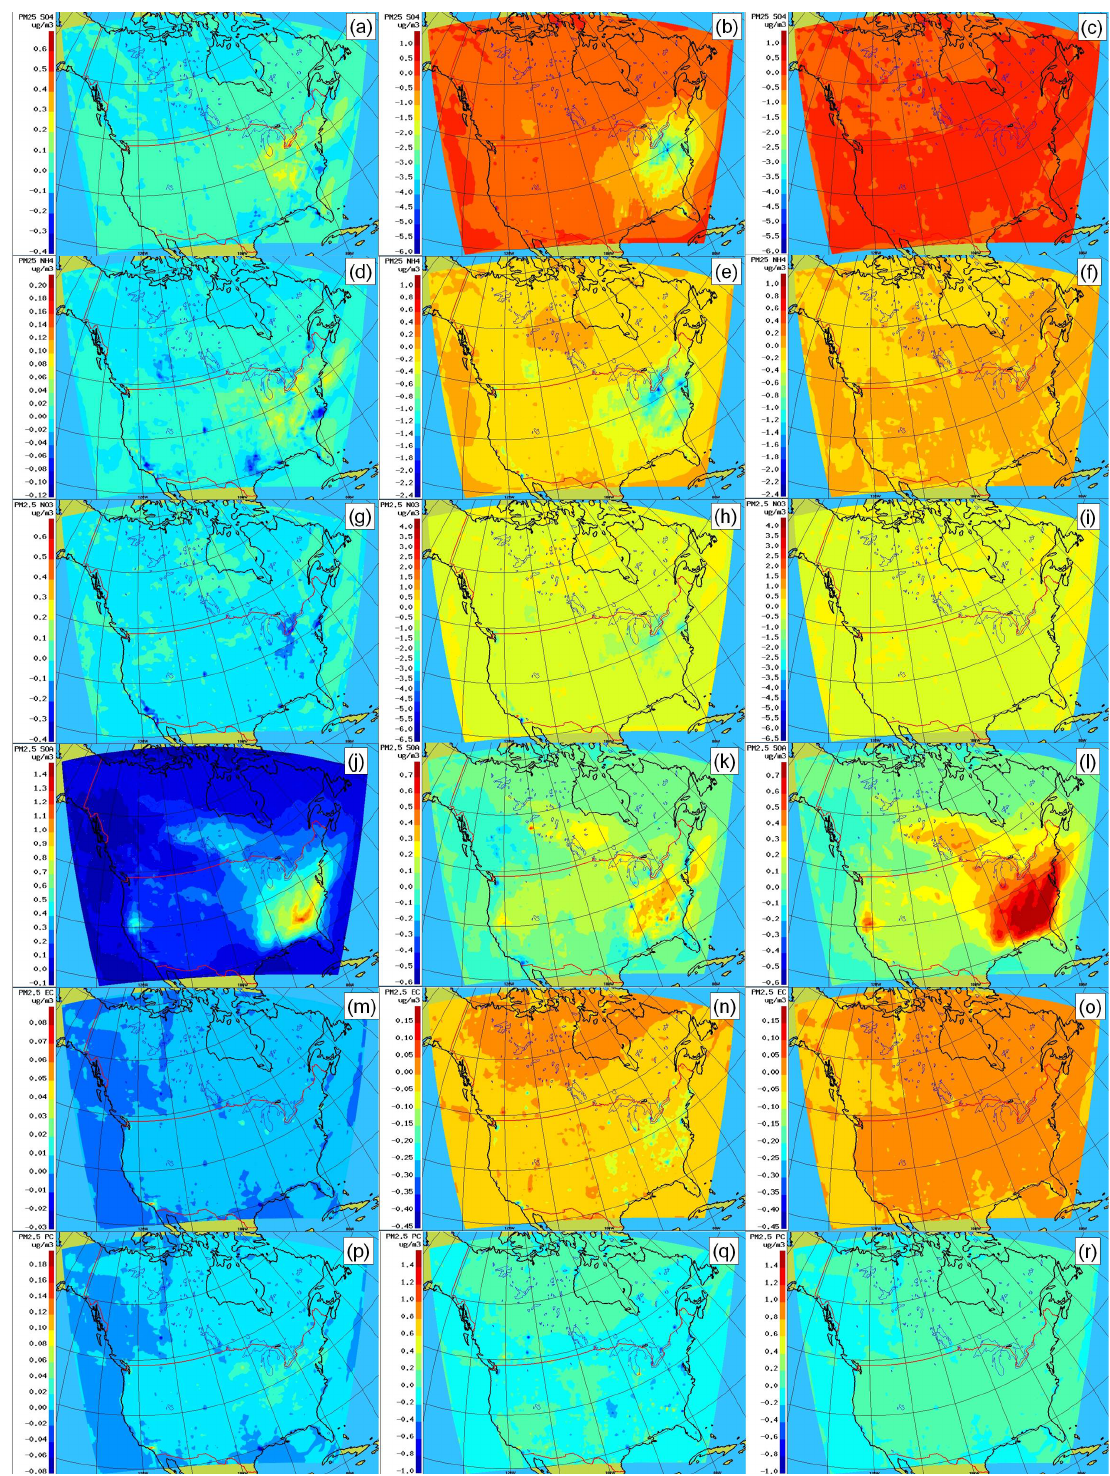
Fig. 9. Chemical speciation of differences in 10yr average summer particle mass, Future–Current, for the two future scenarios. (a) PM 2 . 5 SO 4 : 1 CC. (b) PM 2 . 5 SO 4 : 1 CE. (c) PM 2 . 5 SO 4 : 1 CC, with the colour scale of 1 CE. (d, e, f) PM 2 . 5 NH 4 , as in (a, b, c) . (g, h, i) PM 2 . 5 NO 3 , as in (a, b, c) . (j, k, l) PM 2 . 5 secondary organic aerosol, as in (a, b, c) . (m, n, o) PM 2 . 5 Elemental Carbon, as in (a, b, c) . (p, q, r) PM 2 . 5 primary organic aerosol, as in (a, b, c)